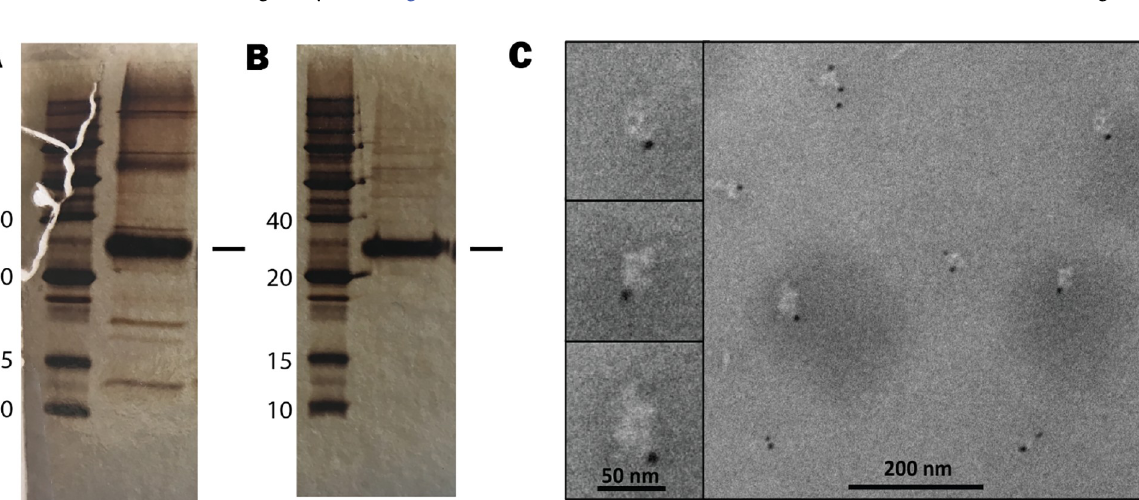
PLOS ONE | https://doi.org/10.1371/journal.pone.0206692 November5,